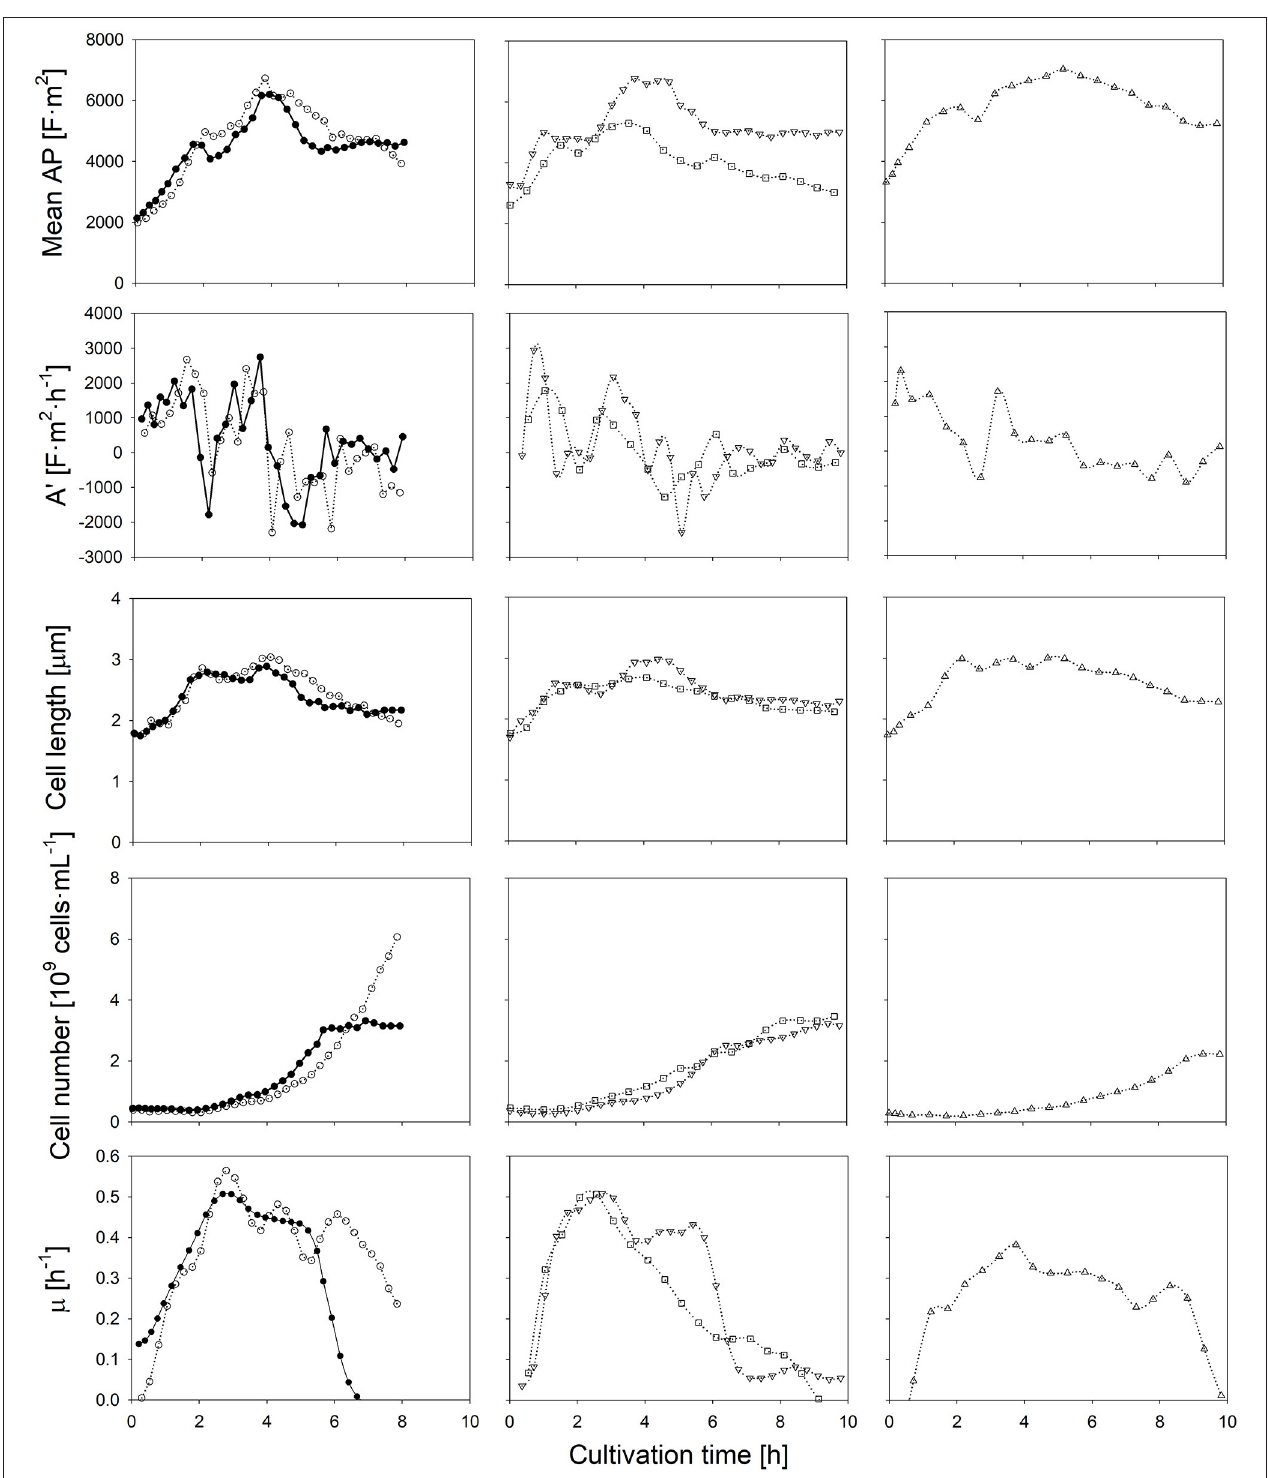
FIGURE 2 | Time course of the mean anisotropy of polarizability (AP), its first derivate, cell length, the amount of cells and the specific growth rate throughout six L. plantarum batch cultivations: at standard conditions (•), with additionally 1% of glucose in the medium ( ◦ ), without pH control ( (cid:3) ), with aeration ( ▽ ) and at a reduced temperature of 25 ◦ C ( △ ). Error bars depicting the technical error of the polarizability measurement have not been represented, thus enabling the comparison between cultivation conditions.